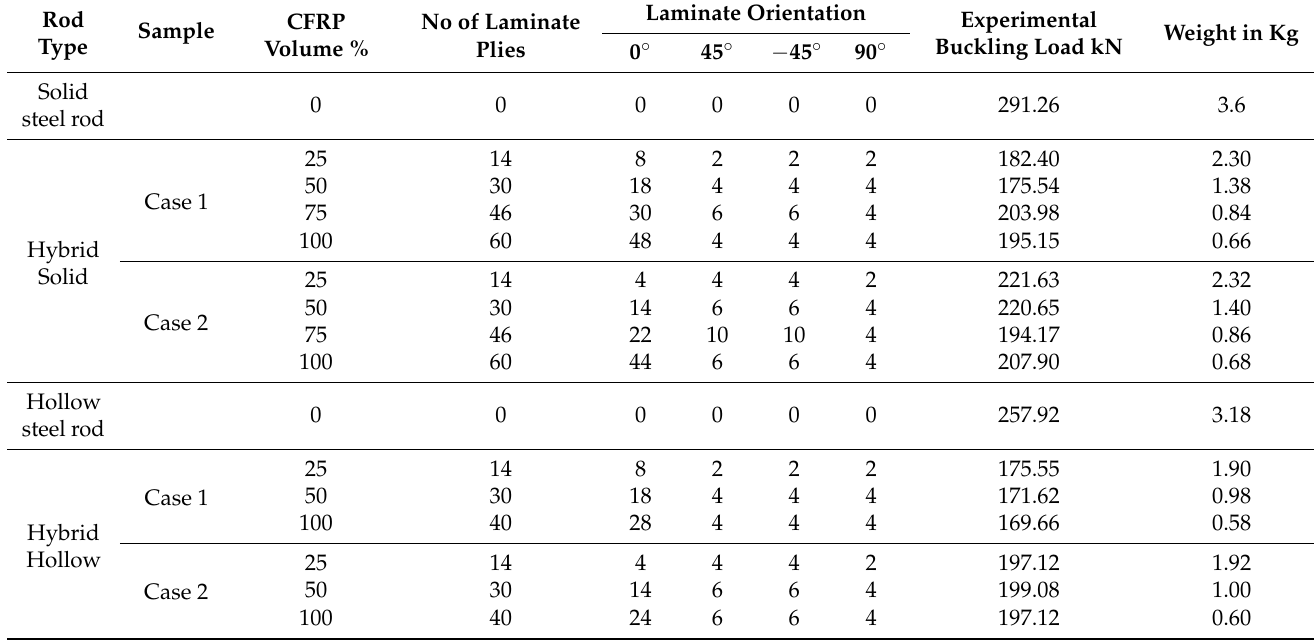
Table 5. Experimental data for hybrid (Steel + CFRP)